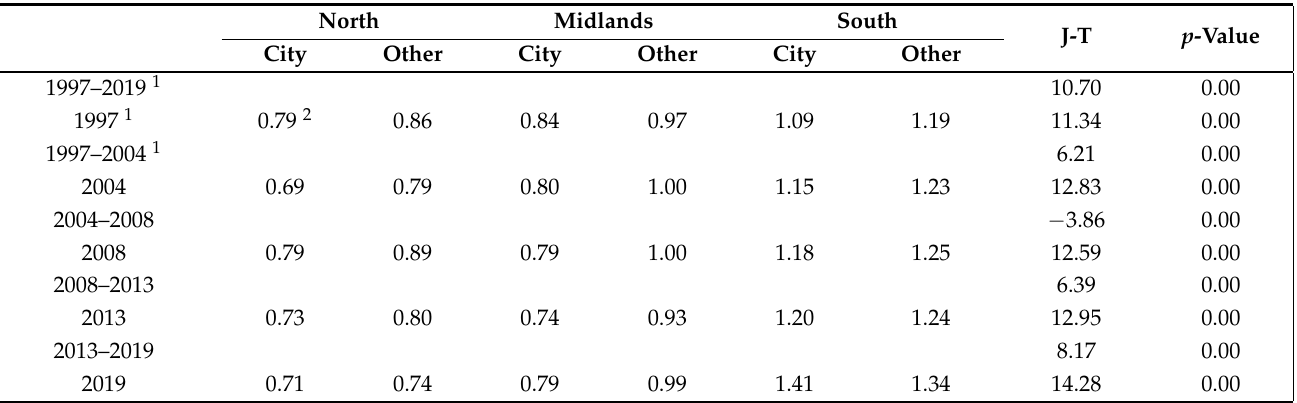
Table 1. J-T Growth